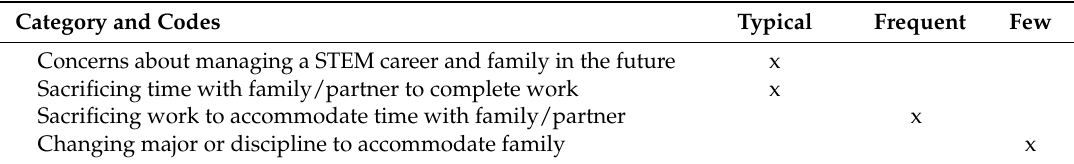
Table 4. Incidents of Work and Life Balance